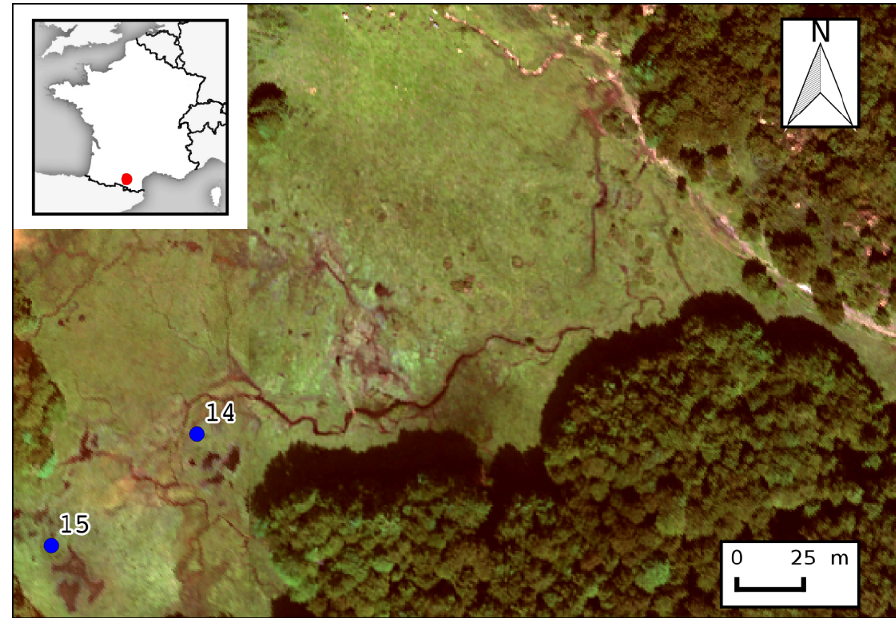
Figure A13. Location of the in situ spectroradiometer measurements for the plots of Rhododendron ferrugineum (RHFR).